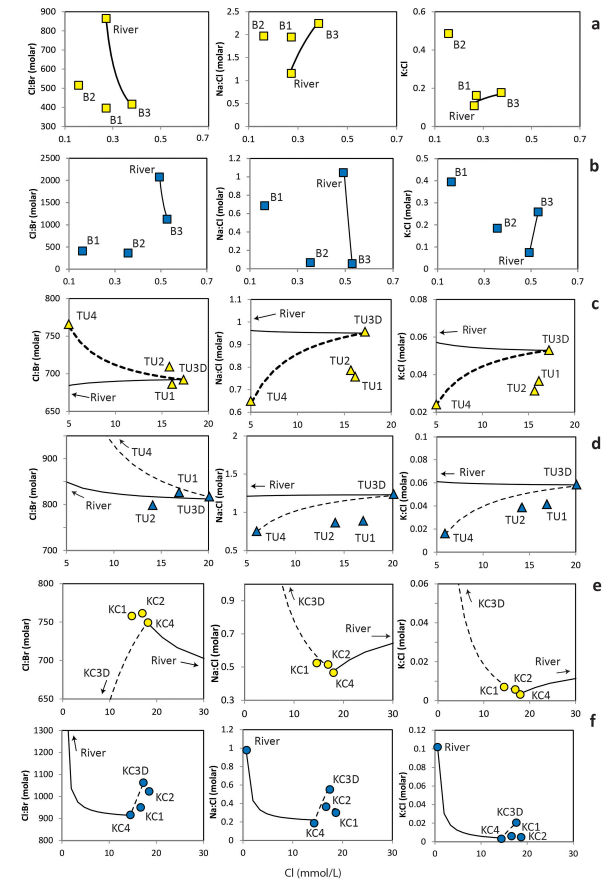
Figure 11. Predicted mixing curves between river water and groundwater at Bruthen (a, b) , Tambo Upper (c, d) and Kelly Creek (e, f) constructed using the endmember compositions from Tables 1 to 3. Yellow data points – February 2011; blue data points – August